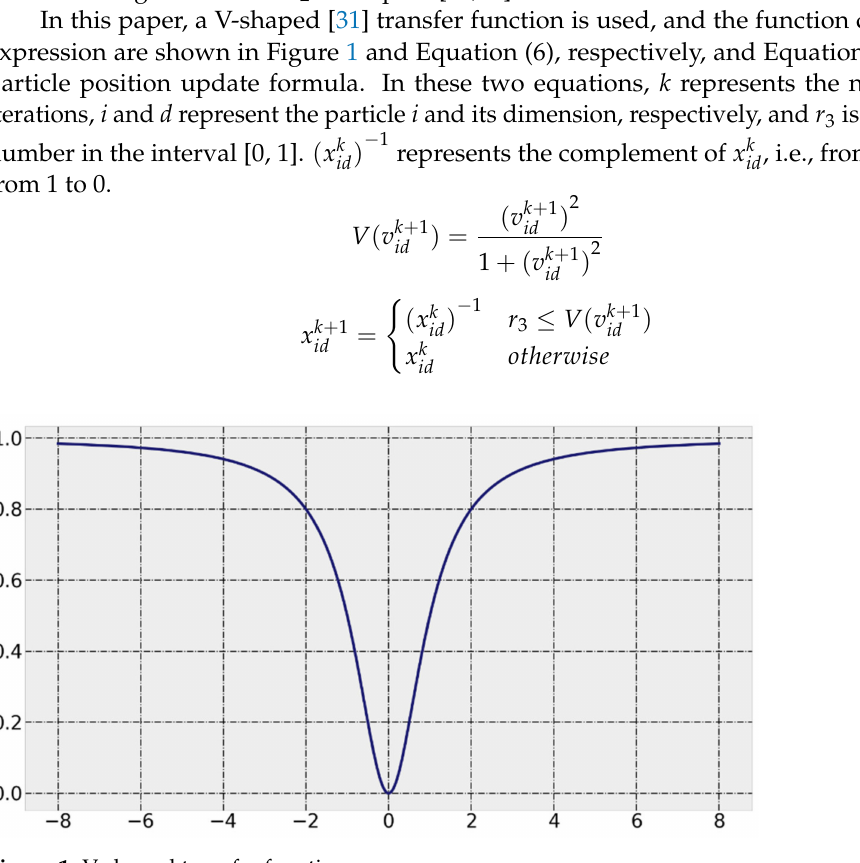
Figure 1. V-shaped transfer